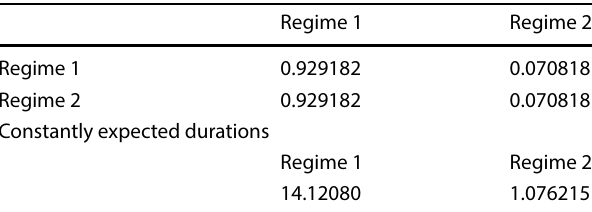
Table 3 Constant Markov transition probabilities and expected durations for the OK